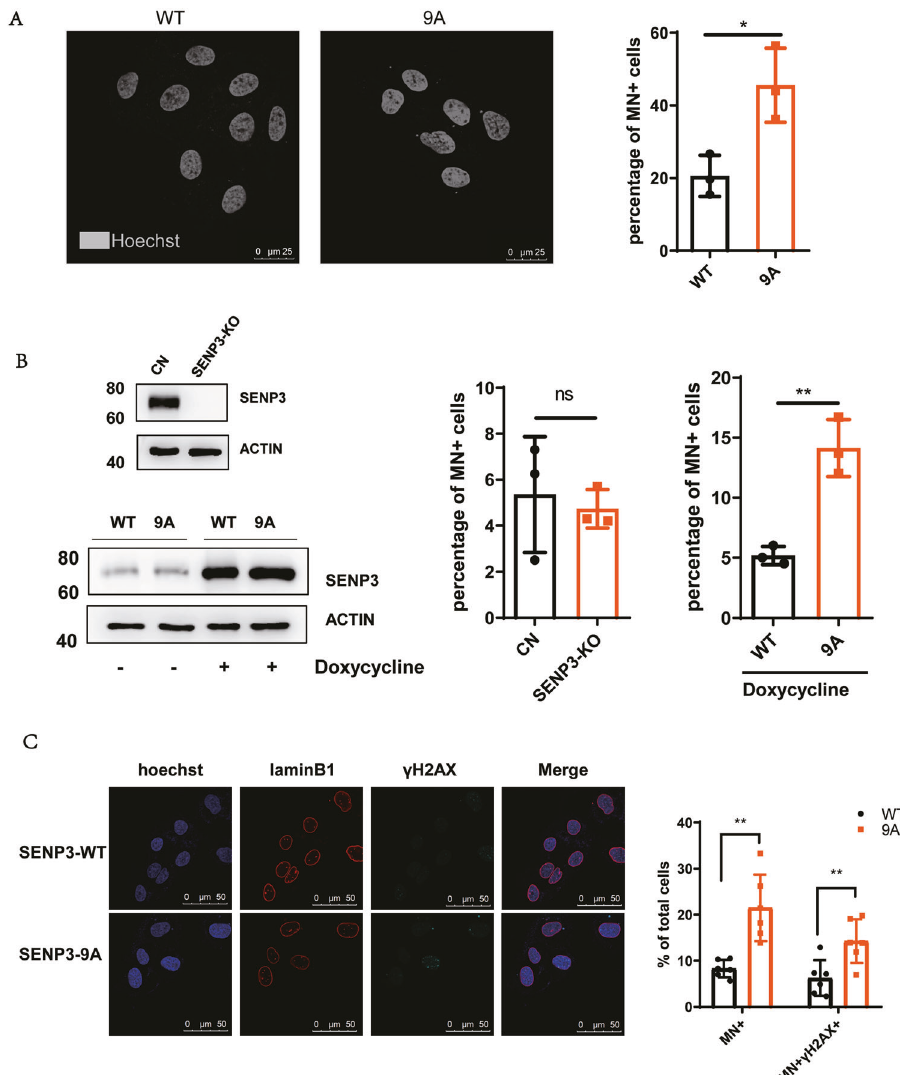
Fig. 3 Mitotic SENP3 activation promotes micronucleus formation. A SENP3-WT- or SENP3 – 9A-U2OS cells were stained with Hoechst. The micronuclei were analyzed by using a confocal microscope. The micronucleus staining positive cells (percentage of total cells) were quantitatively analyzed on 30 fi elds pictured by a confocal microscope. Data are represented as mean with SD. * P < 0.05. B SENP3 in U2OS cells were knocked out by using Cas9/CRISPER system plasmid px459 encoding human SENP3 gRNAs (Top of left panel). Then SENP3 KO U2OS cells were stably transfected with Doxycycline-induced SENP3-WT (WT) or SENP3 9A (9A) plasmids. The expression of SENP3-WT or SENP3 – 9A mutant in these cells were induced by the addition of doxycycline(1 μ M/mL) for 48 h (bottom of left panel). The micronuclei were stained with Hoechst and quantitatively analyzed on 30 fi elds pictured by confocal microscope (right panel). Data are represented as mean with SD. ** P < 0.01. C SENP3-WT- or SENP3 – 9A-U2OS cells were immune-stained with anti-Lamin B1 or anti- γ H2AX antibody, and co-stained with DAPI. The co-localization of micronuclei with γ H2AX was quantitatively analyzed on 30 fi elds pictured by confocal microscope. Data are represented as mean with SD. ** P <